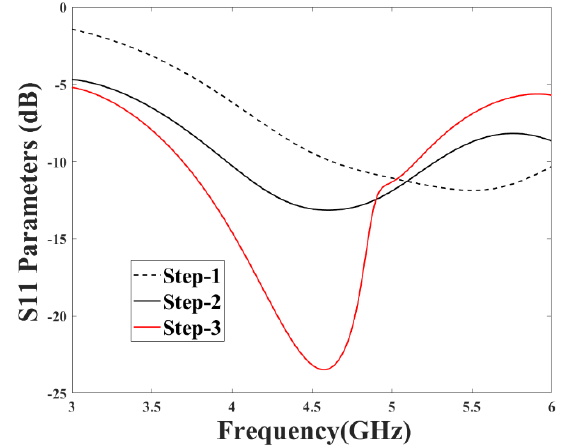
Figure 3. S – parameters for different configuration. Figure 3. S–parameters for different configuration.